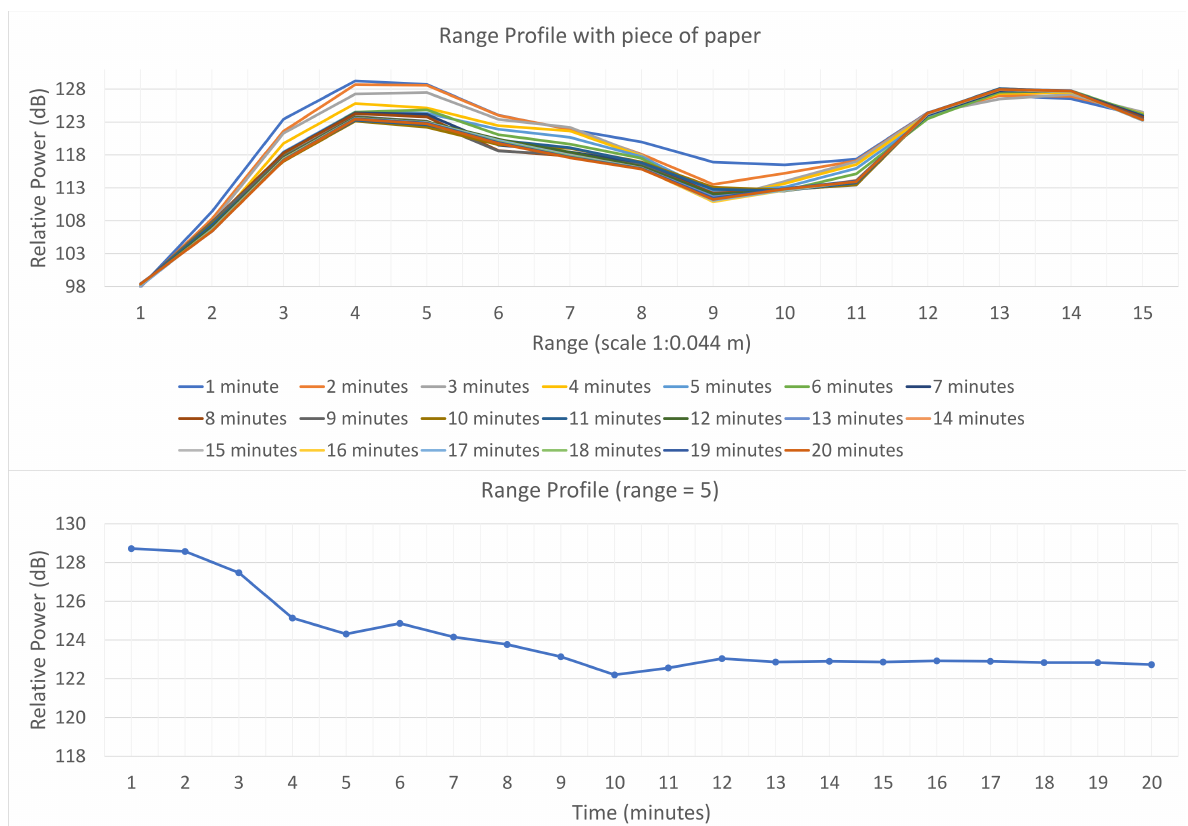
Figure 12. Test results with a sprayed piece of